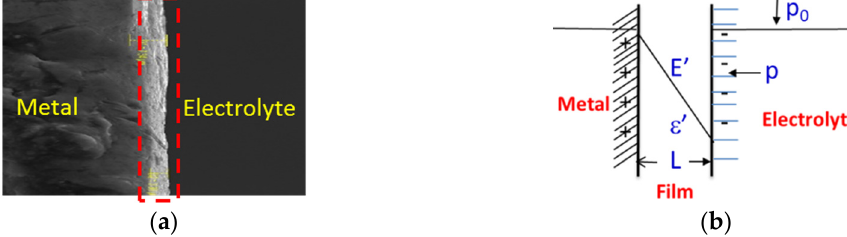
Figure 4. Interface between electrode surface and electrolyte: ( a ) SEM and ( b ) electrical double layer model of oxide film redrawn from [35]. Reproduced with permission from N. Sato, Vol. 16, 1683–1692, Electrochimica Acta; published by Elsevier, October 1971.